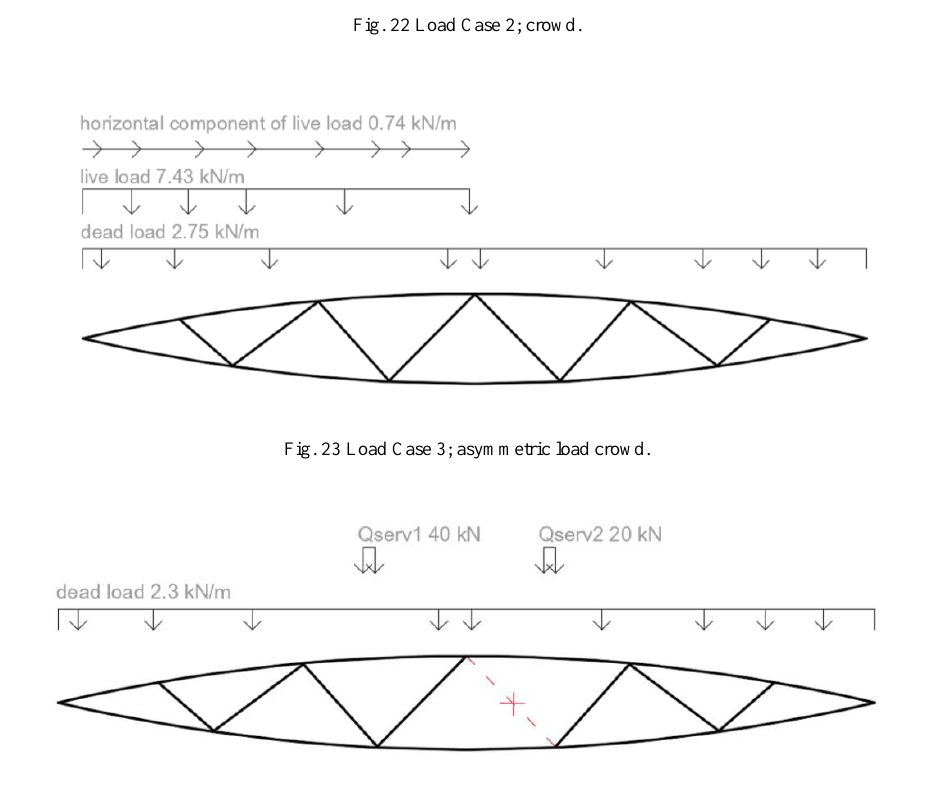
Fig. 22 Load Case 2; crowd.